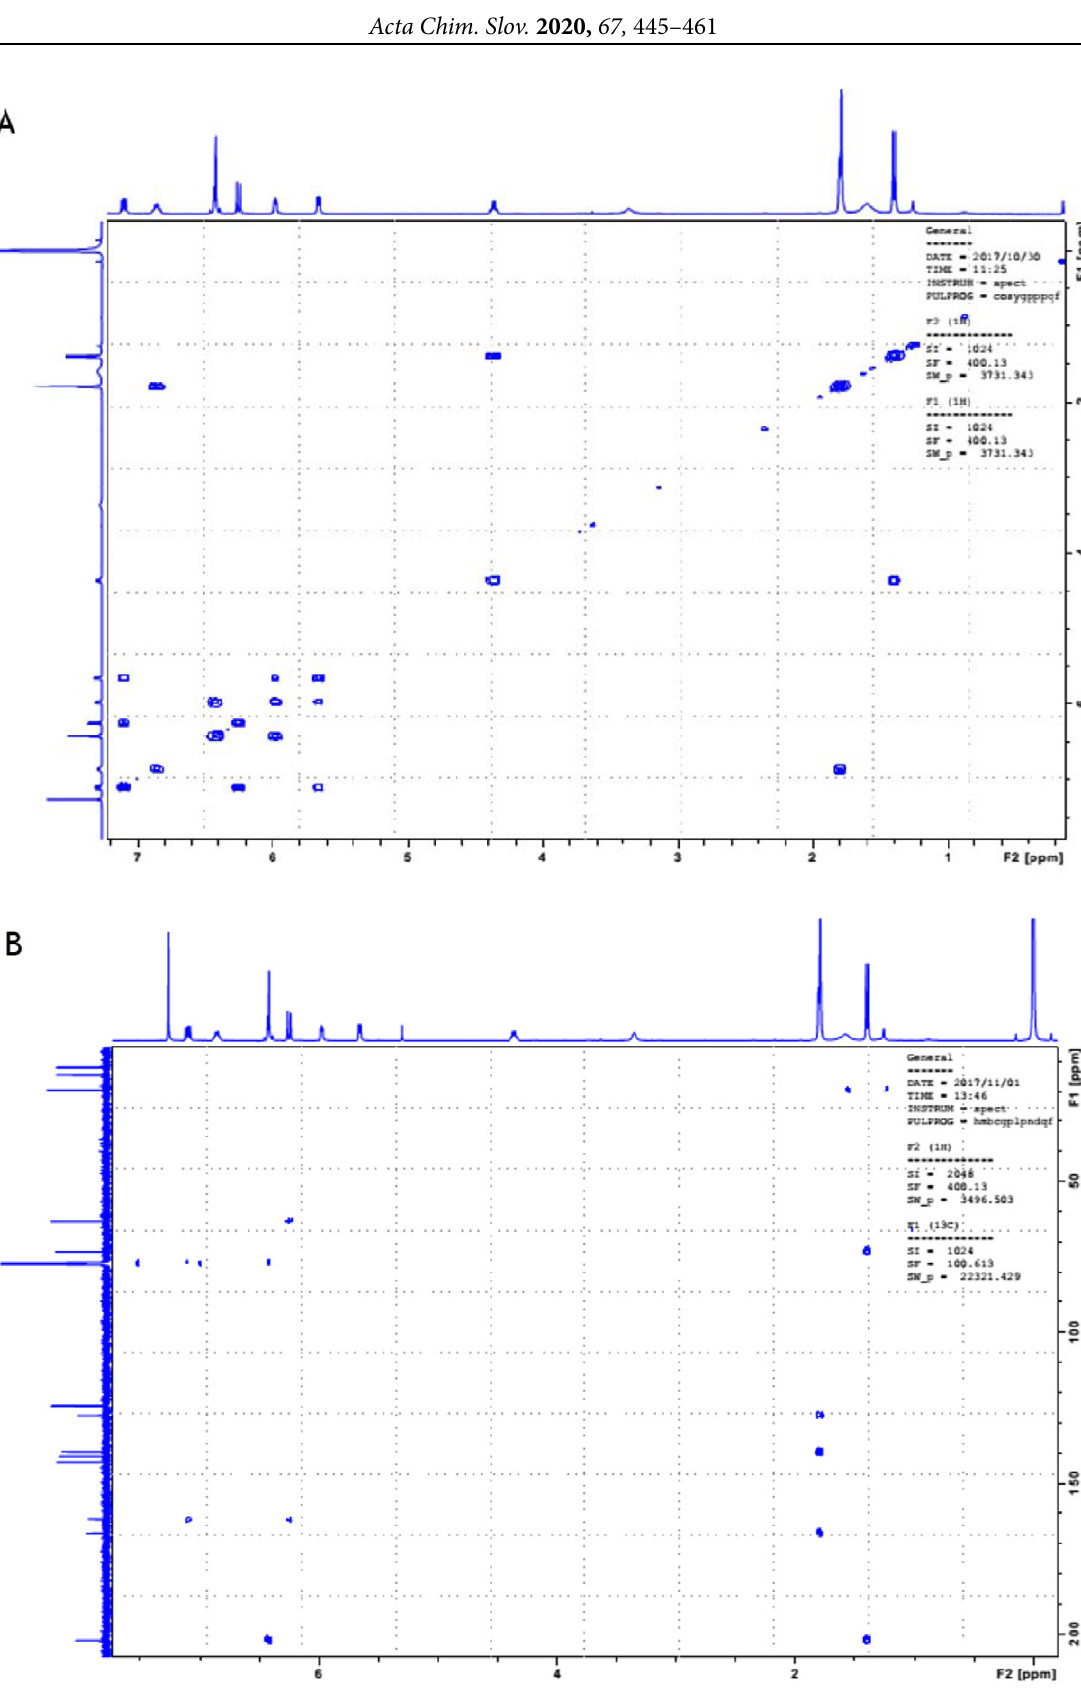
Figure 10. HSQC (A) and COSY (B) spectra of compound